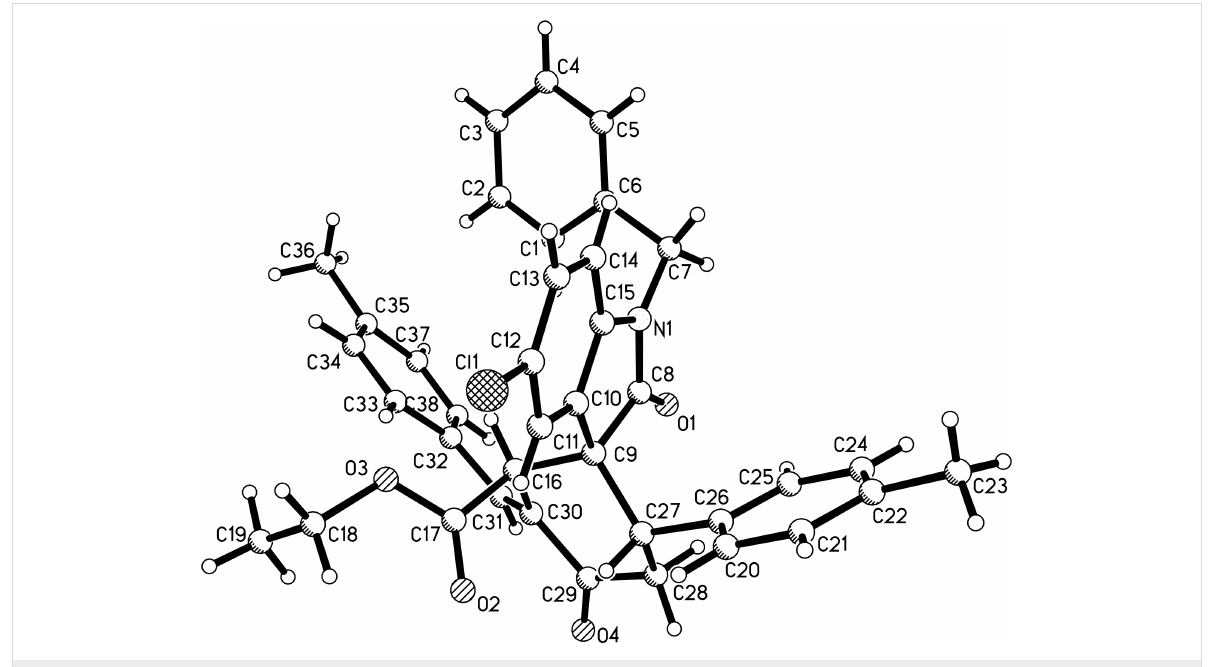
Figure 4: Single crystal structure of compound 5a .